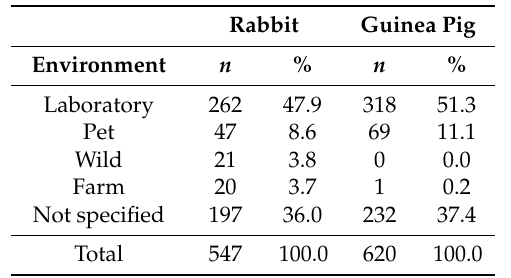
Table 2. Environment from which data were collected, or audience at which the citation was aimed, for 547 rabbit citations and 620 guinea pig